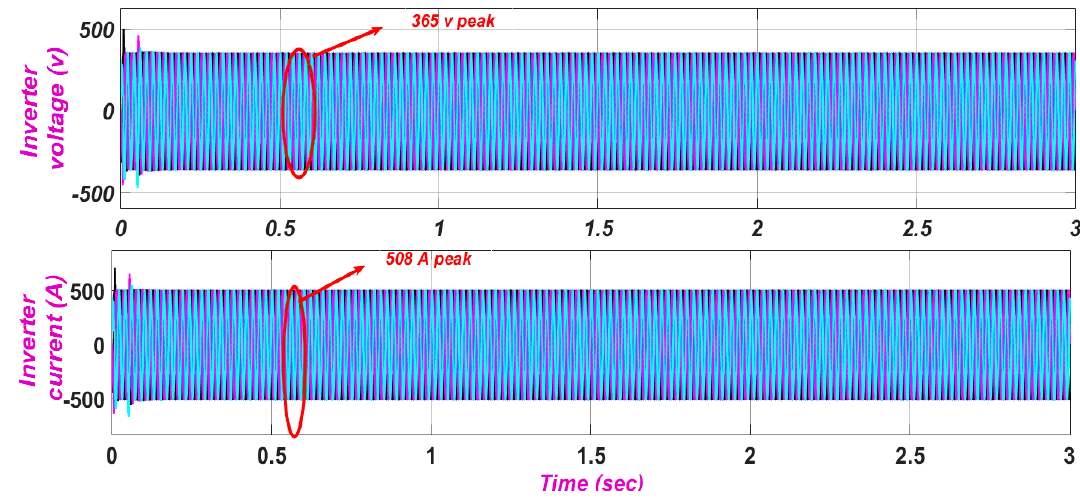
Figure 14. Inverter Output Voltage and Inverter Current.